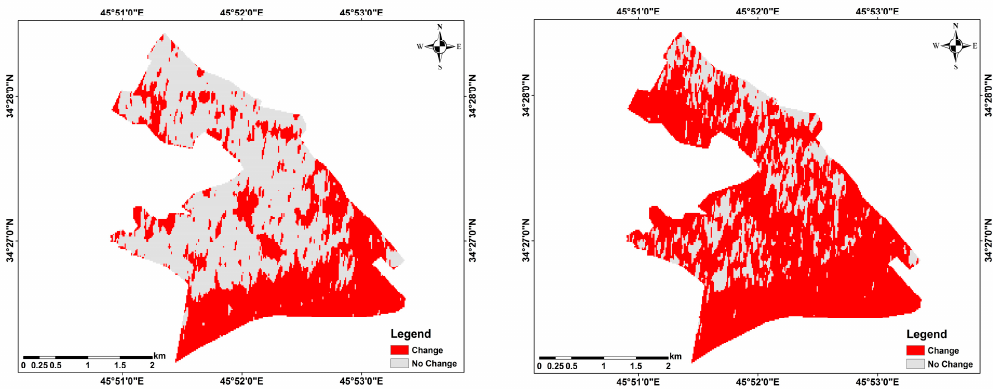
Figure 3. Sarpol Zahab coherence image classified into change and no change showing period before (7 November 2017, left ) and after (1 December 2017, right ) the earthquake.